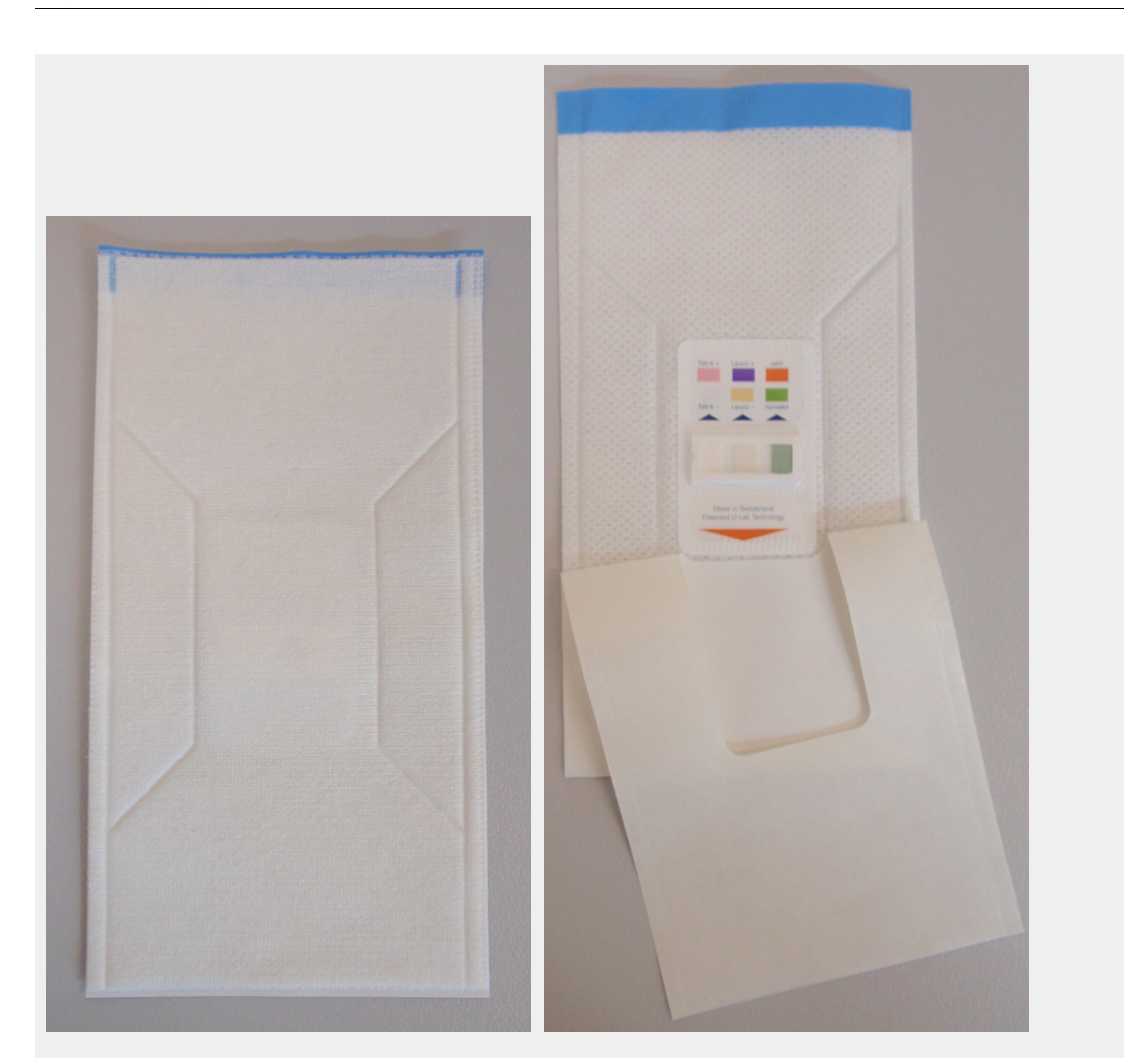
The front side of U-Test ® facing the patients’ body is shown on the left side. On the right side the back side of U-Test ® is shown with the adhesive tape serving to fix the device into the baby’s